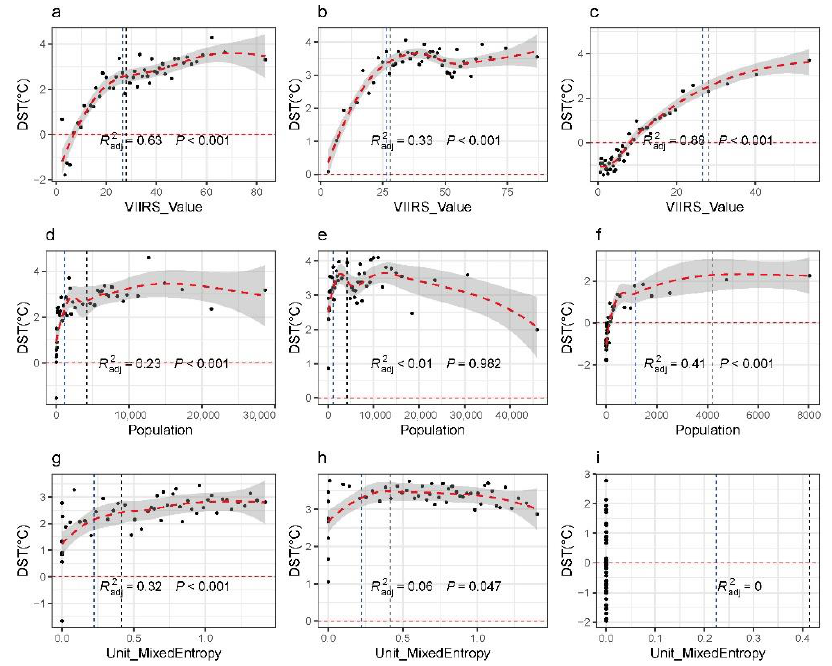
Figure 12. Single-factor scatter plots and fitting curves of DST to three surface social-economic indicators. Subgraphs ( a , d , g ) are for the group of functions for A, G and R; ( b , e , h ) are for the group of functions for B, M, S and W; ( c , f , i ) are for Non-construction areas. The vertical blue dotted line is the median value and the black one is the mean value of the corresponding independent variables; the horizontal red dotted line is the zero value of DST.